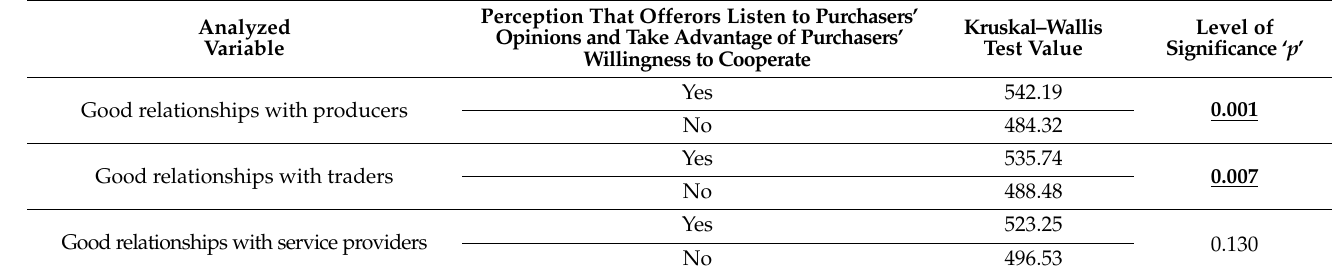
Table 3. Significance of different opinions between respondents: the importance of good relationships with offerors according to the perception of offerors as entities that listen to purchasers’ opinions and take advantage of their willingness to cooperate.